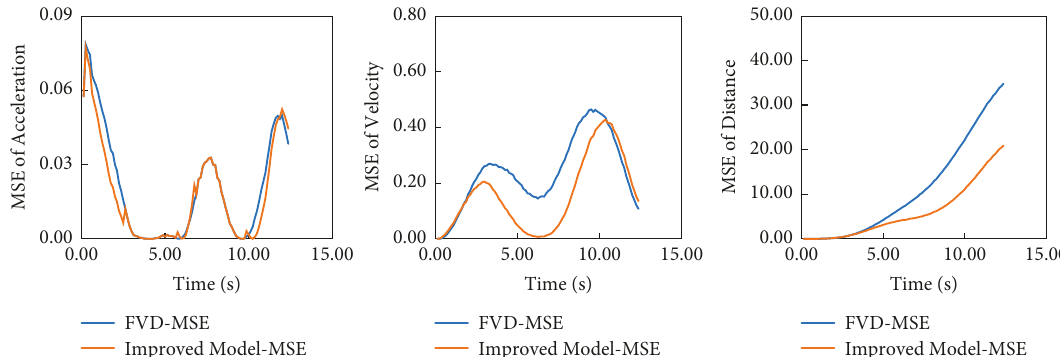
Figure 10: The curves of a subject vehicle’s acceleration, speed, and distance in a car-car scenario.